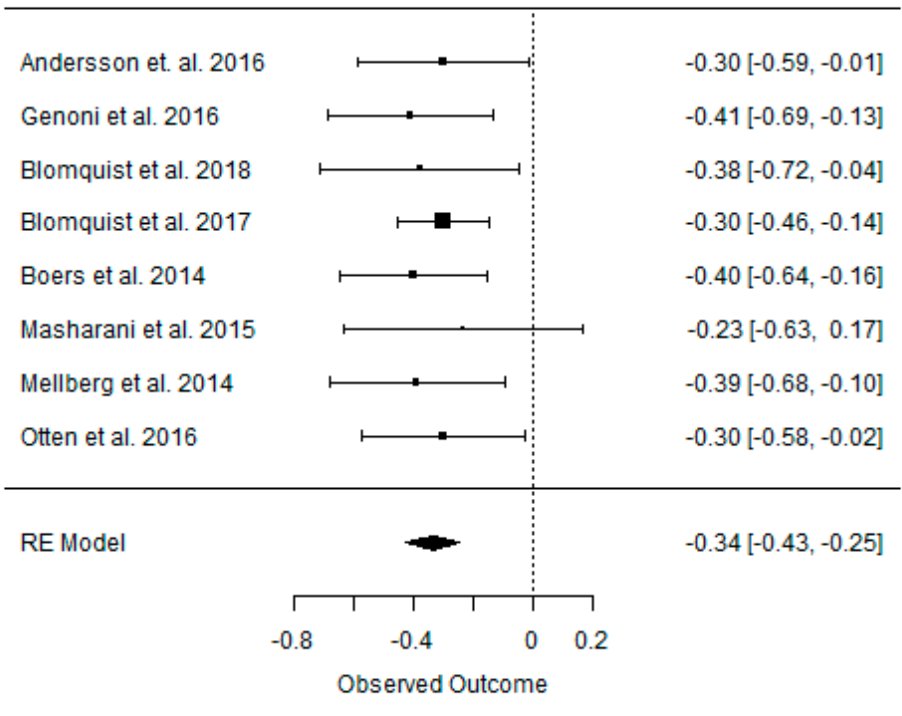
Figure A17. Forest plot of the effect of a PDs on TG in the short term (weighted mean difference).